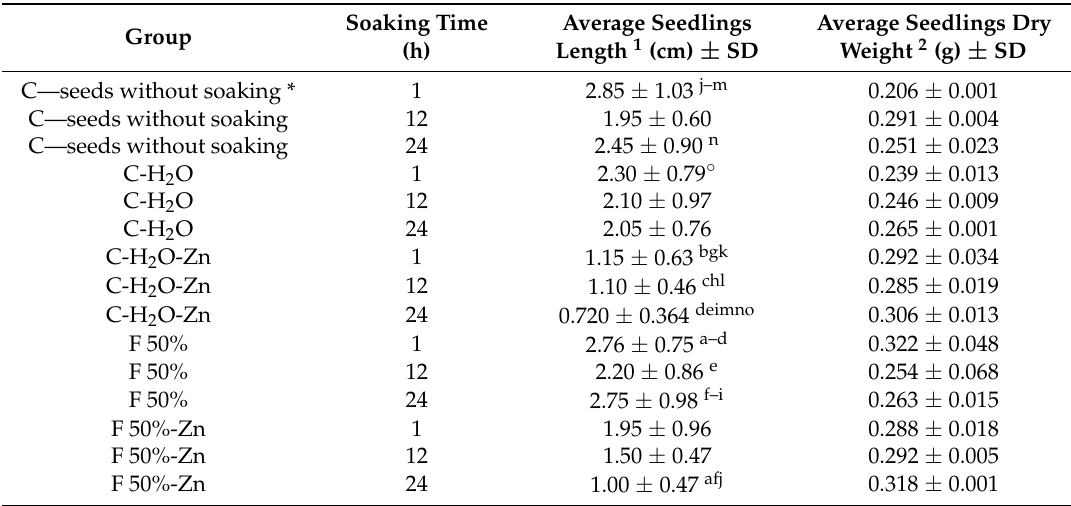
Table 4. The effect of soaking time on the length and weight of the seedlings ( N = 2). Soaking Time Group